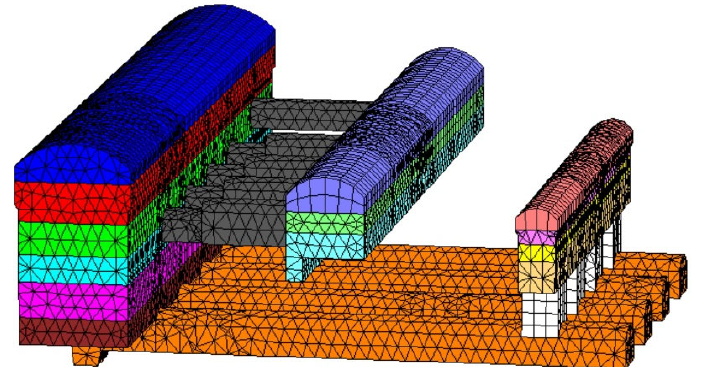
Figure 13. The computing grid of excavated rock.